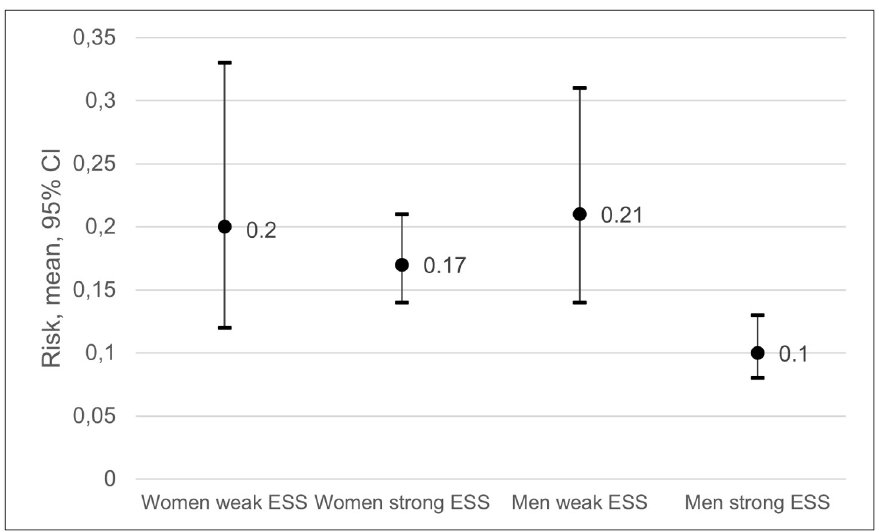
https://doi.org/10.1371/journal.pone.0283222.g004